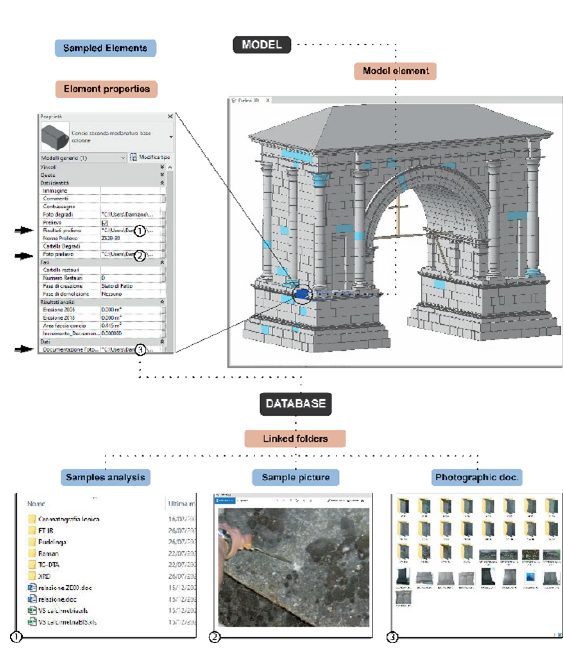
Figure 4: the blue ashlars are the location of samples for the different analysis made by RAVA laboratory. On the bottom part, all the types of documents connected with the single element by the URL to allow a direct